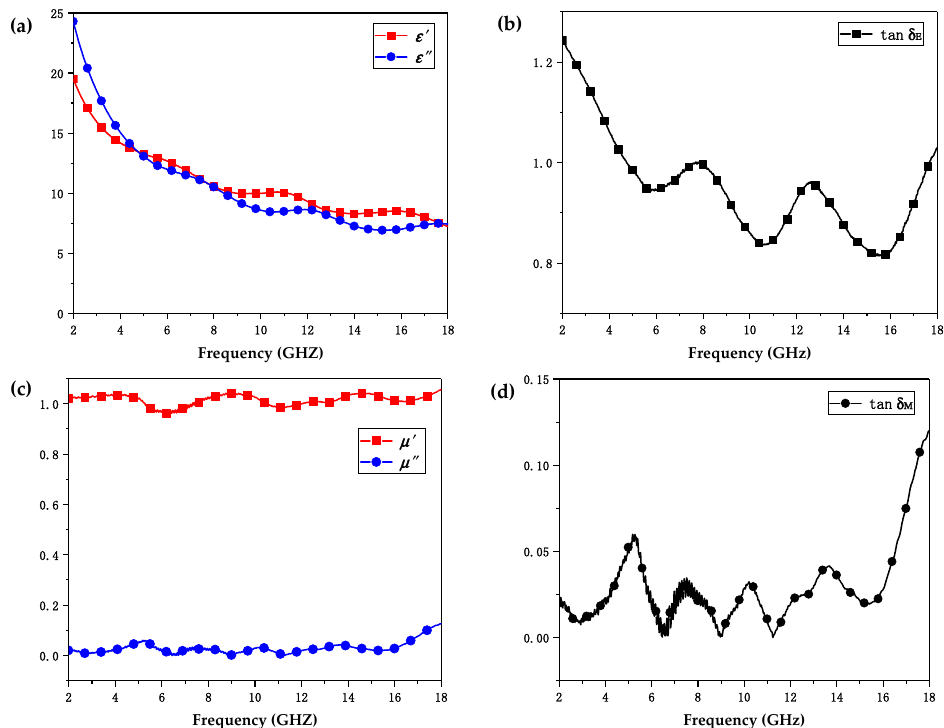
Figure 5. Electromagnetic property of conductive ABS. ( a ) Real parts ( ε (cid:48) ) and imaginary parts ( ε (cid:48)(cid:48) ) of the complex relative permittivity. ( b ) The dielectric loss tangent tan δ E . ( c ) Real parts ( µ (cid:48) ) and imaginary parts ( µ (cid:48)(cid:48) ) of the complex relative permeability. ( d ) The magnetic loss tangent tan δ M .